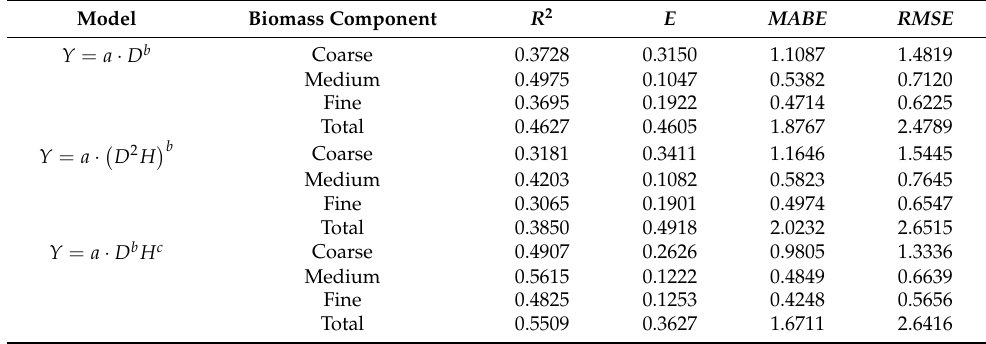
Table 4. R 2 , E , MABE , and RMSE for the three biomass models.